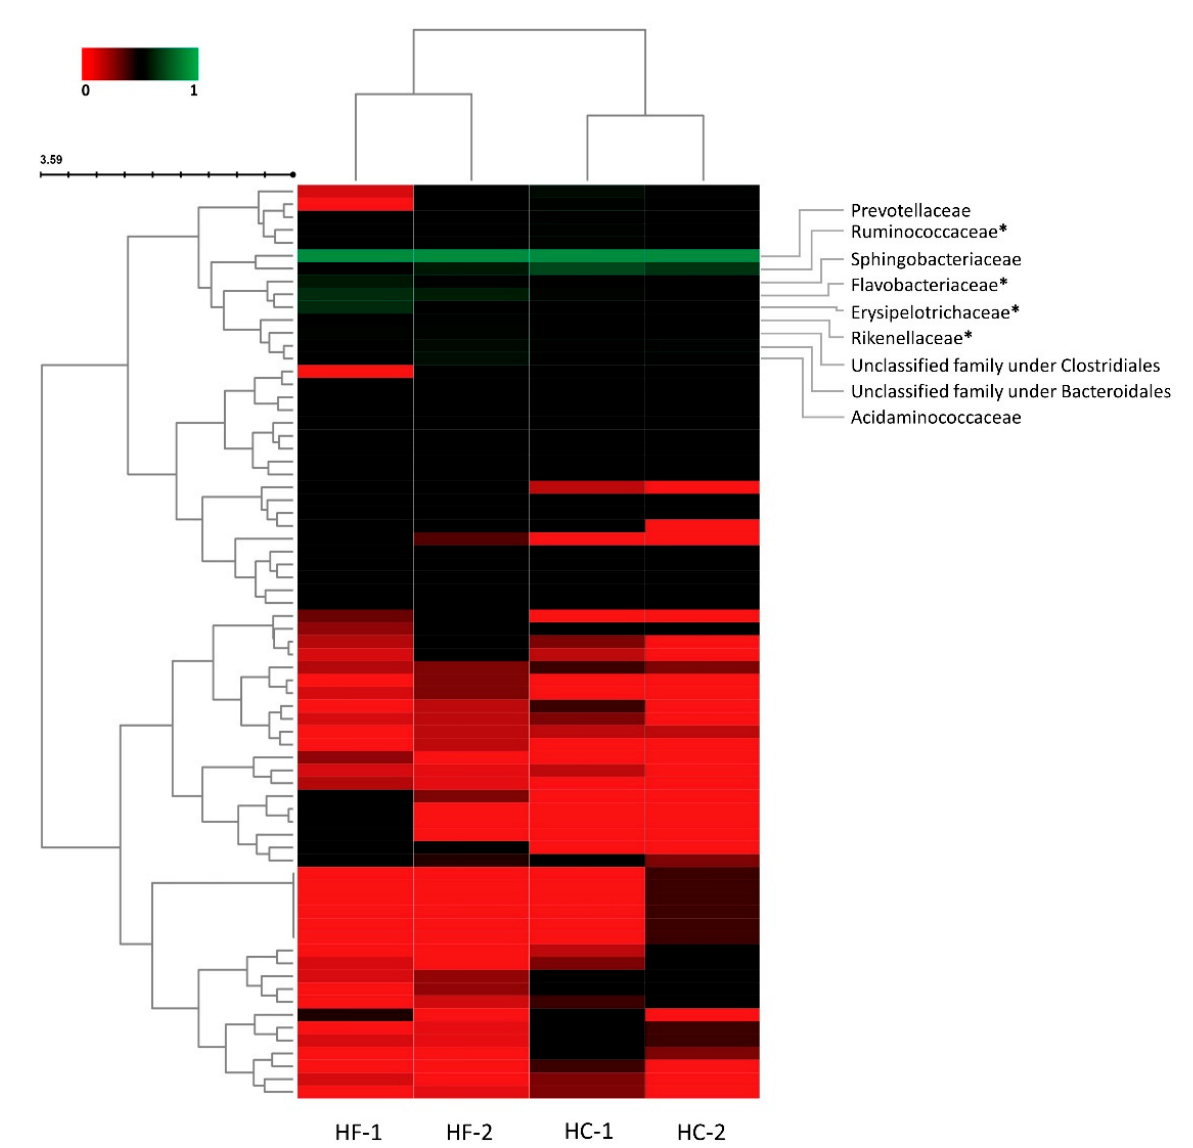
Figure 3. Heatmap clustering of observed families (rows) based on normalized value (0–1) of relative abundance per treatment (columns) using Bray-Curtis dissimilarity test and Ward linkage. Figure generated using Interactive Cluster Heatmap library (InCHlib) [49]. HF-1, high-forage diet; HC-1, high-concentrate diet; HC-2, high-concentrate diet; HF-2, high-forage diet. Asterisk (*) denotes significant differences ( p < 0.05).